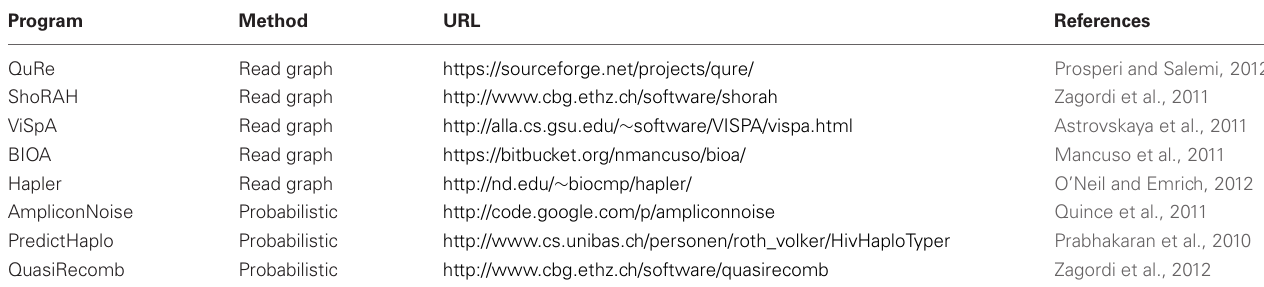
Table 1 | Available software tools for viral quasispecies